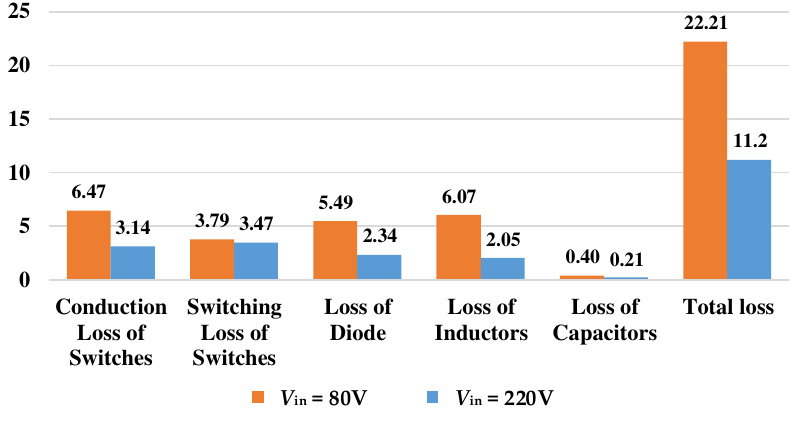
Figure 11. Distribution of power loss.